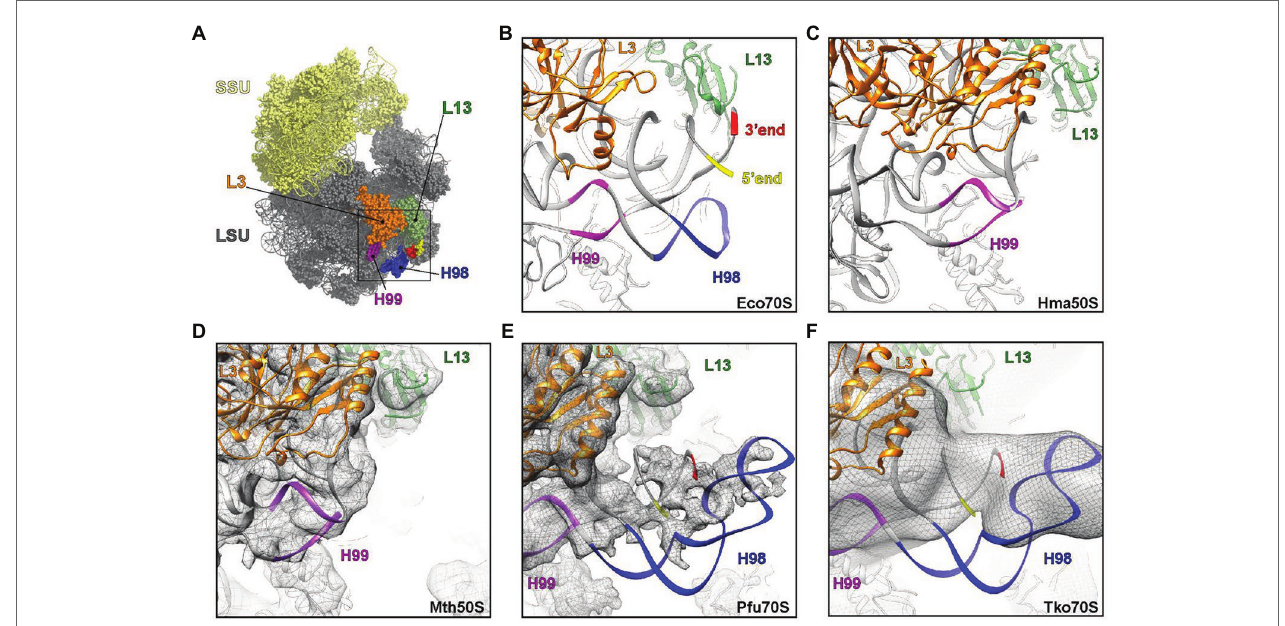
FIGURE 5 | Visualization of H98 in structures of ribosomal particles from bacteria and archaea. (A) Overview of the E. coli ribosome with the SSU in yellow and the LSU in gray. Ribosomal proteins L3 (orange) and L13 (green) are highlighted for reference as are 23S rRNA helices H98 (blue), H99 (purple), and the 5 ´ (red) and 3 ´ (yellow) ends. (B–F) View of the large ribosomal subunit highlighting the region, where H98 (blue), H99 (purple), and the 5 ´ and 3 ´ ends are located in (B,C) the crystal structures of the (B) E. coli 70S ribosome (PDB ID 5GMP) and the (C) Haloarcula marismortui 50S subunit (PDB ID 4V9F), as well as cryo-electron microscopy structures of the (D–F) Methanothermobacter thermautotrophicus 50S subunit (EMD-2012, PDB ID 4ADX), (E) Pyrococcus furiosus 70S ribosome (EMD-2009, PDB ID 4V6U) and the (F) Thermococcus kodakarensis 70S ribosome (EMD-2170 with PDB ID 4V6U fitted). In (D–F) , the cryo-EM map density is shown as a gray